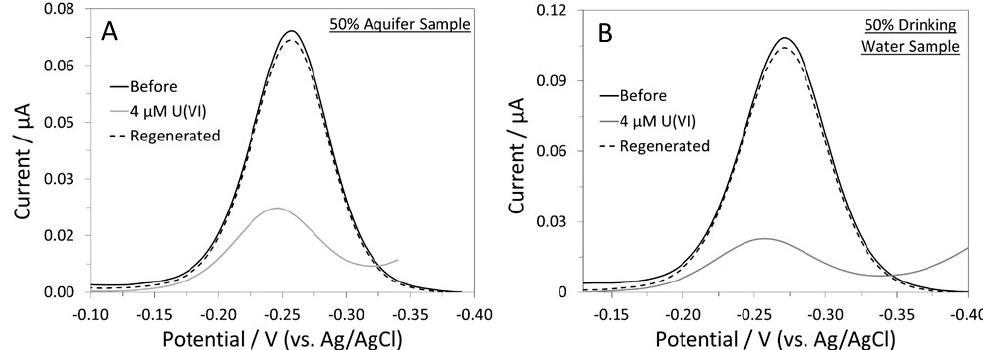
Figure 5. ACVs of the U-pT-12 sensor in ( A ) a 50% synthetic aquifer sample and ( B ) a 50% synthetic drinking water